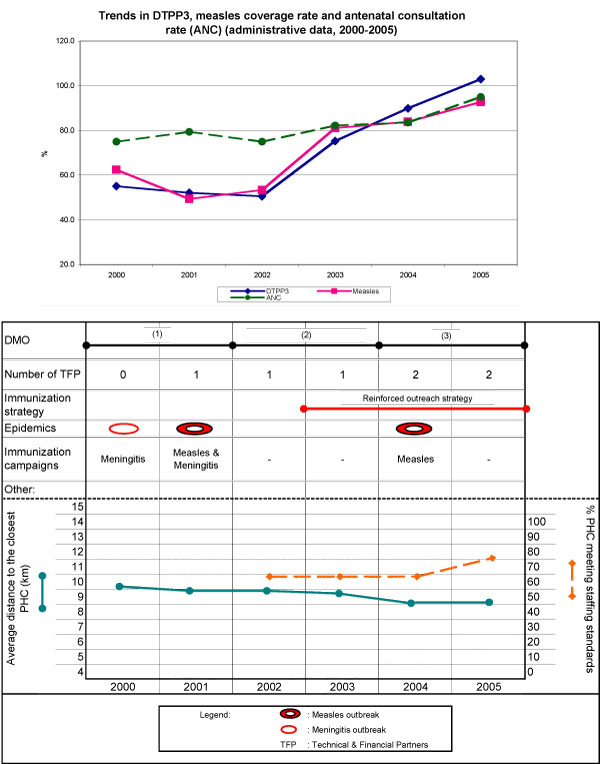
Health district of Bougou.